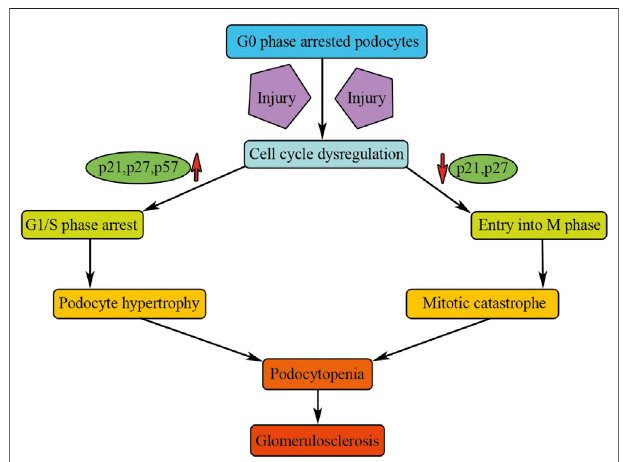
FIGURE 3 | Cell cycle dysregulation of podocytes causes renal fi brosis. Injury could activate podocyte cell cycle entry and results in cell cycle dysregulation of podocytes, causing podocyte hypertrophy or mitotic catastrophe, which will result in podocytopenia and fi nally result in glomerulosclerosis.